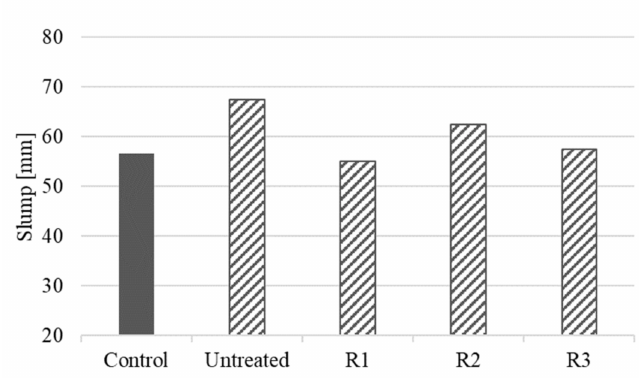
Figure 16. Cone slumps of cement mortars with 5% replacement rubber, grain size T1, using cement C1.